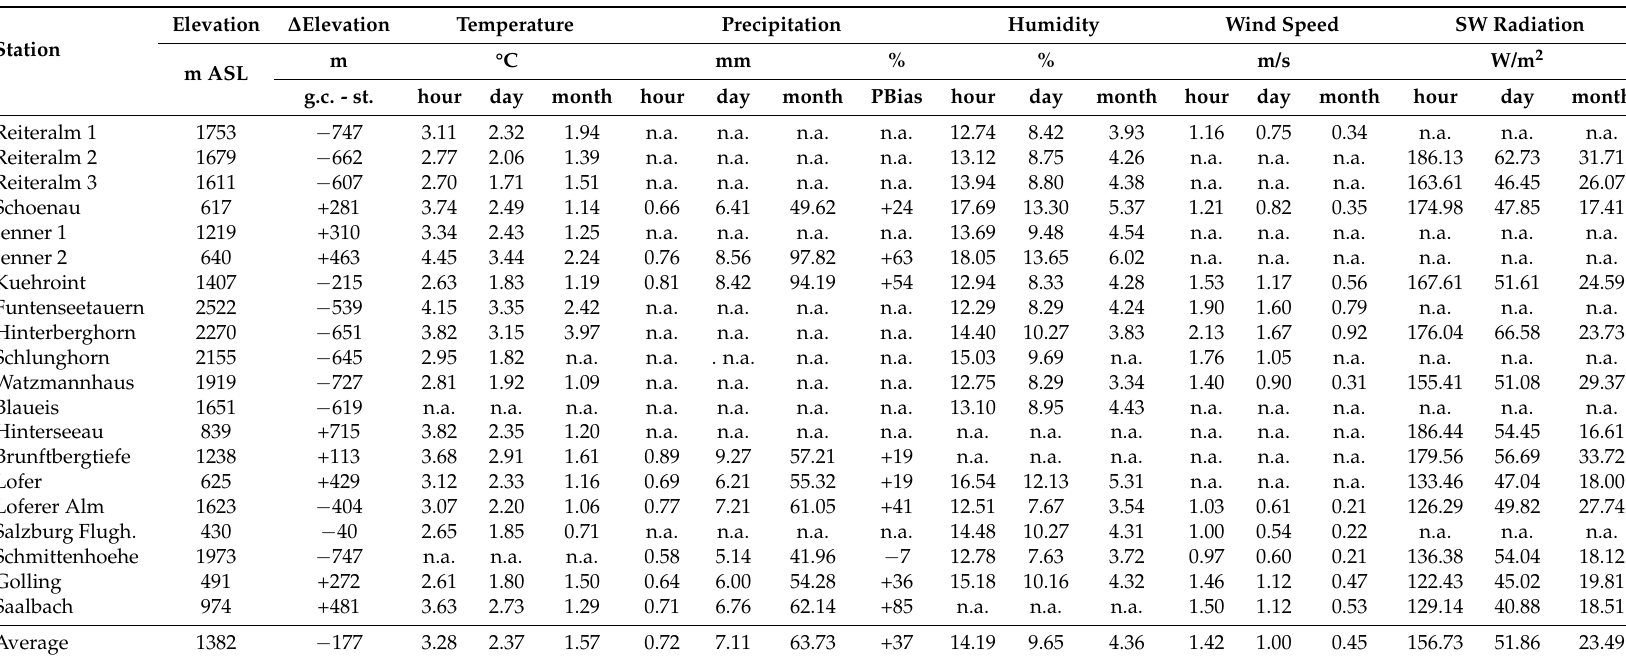
Table 2. RMSE values for WRF (ERA-Interim) results against station data for the period 2001–2009 and the variables temperature, precipitation, humidity, wind speed, and short-wave radiation (hourly, daily, and monthly) and percentage bias (PBias) for precipitation (g.c. = grid cell, st. = station, n.a. = not available).